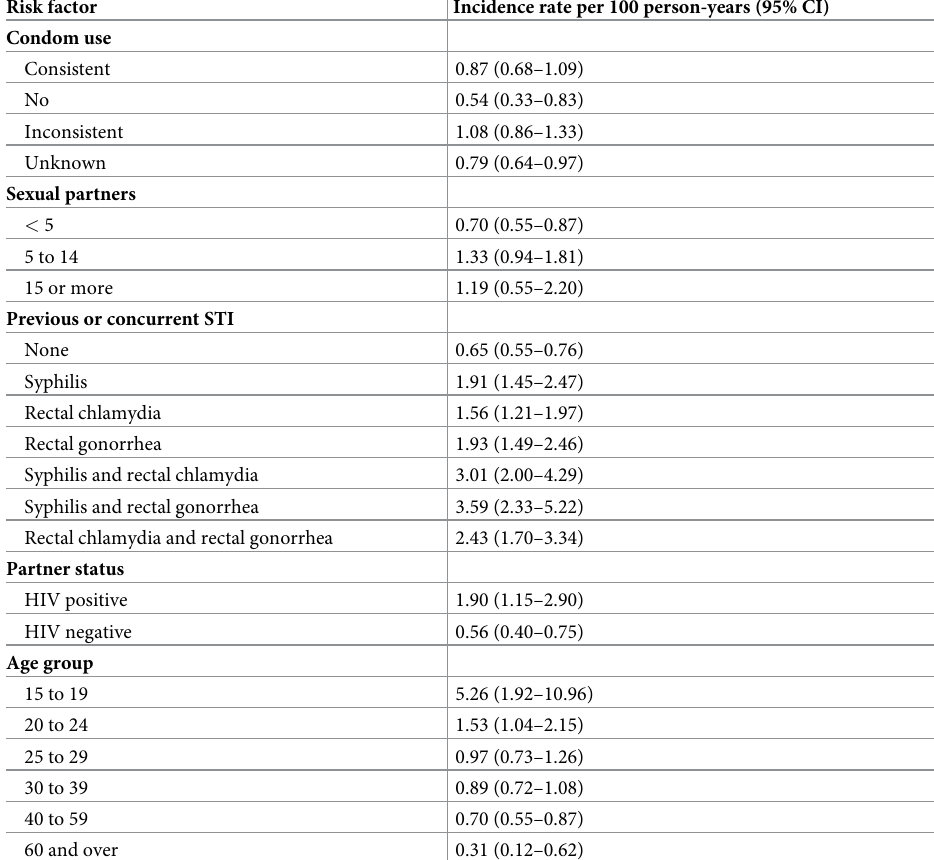
Table 3. Unadjusted incidence rates for HIV seroconversion, by risk factor, during the study period 2004–2017 (N = 9,038